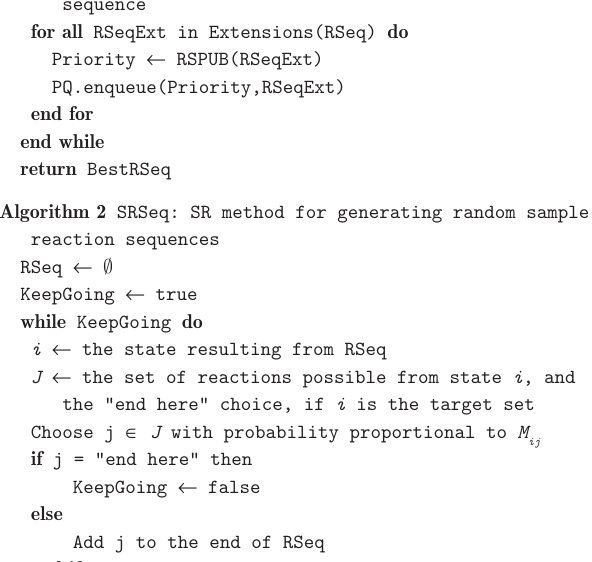
Algorithm 3 NRSeq: NR method for generating random sample